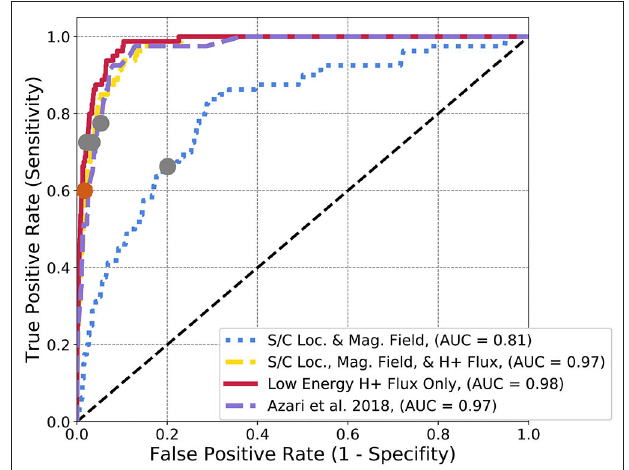
FIGURE 7 | Random forest ROC diagram for Cassini data subsets. The gray dots represent the final optimization location for random forest classification. The orange dot represents the peak HSS value, used for optimization in Azari et al. (2018) . The distinct curves represent separate ROC curves for each subset of data described in section 4. The Azari et al. (2018) subset denotes the usage of S